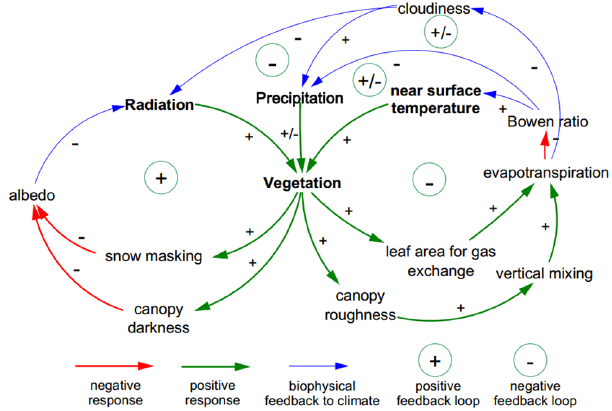
Figure 1. Diagram of climate–vegetation interaction feedback loops that comprise positive responses (green), negative responses (red) arising from vegetation change and consequent biogeophysical feedbacks to climate